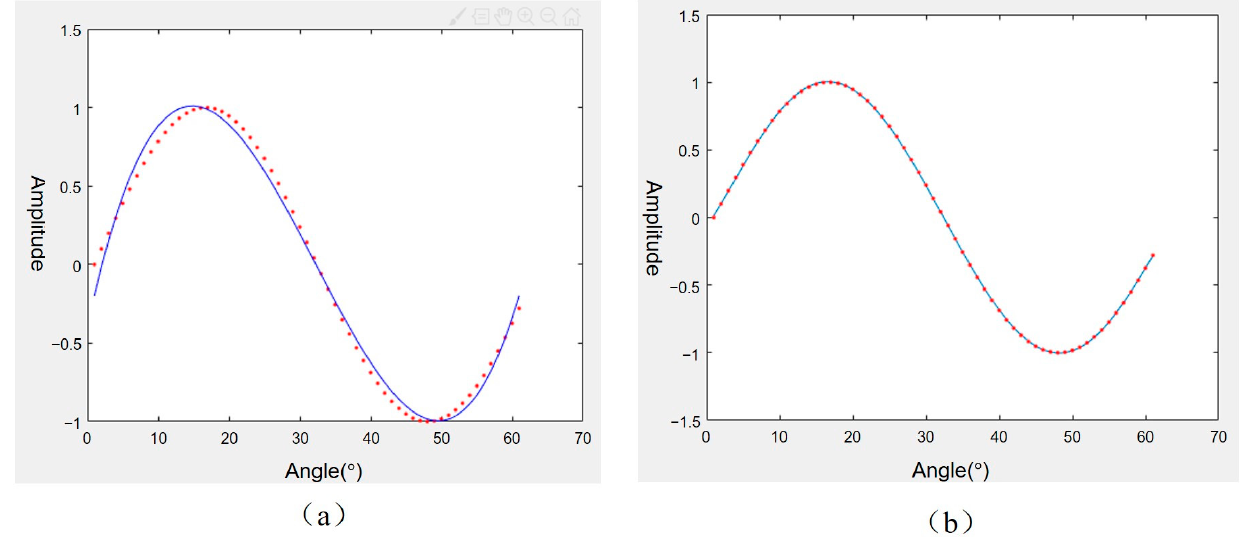
Figure 3. The polynomial regression function (red) approximates the sine function (Blue): ( a ) cubic polynomial approximation and ( b ) quintic polynomial approximation.